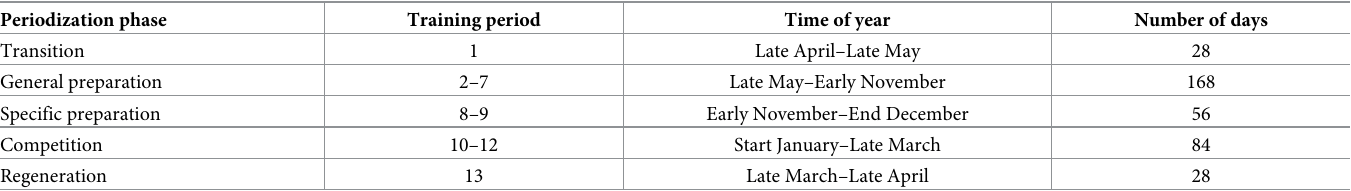
Table 2. A description of the 5 periodization phases across the annual